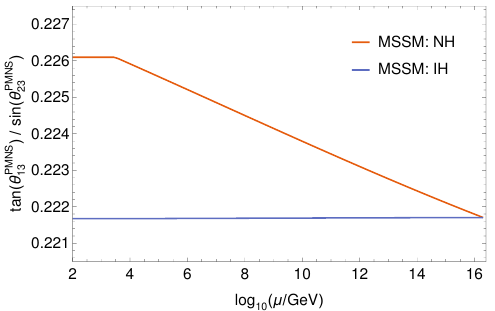
) / sin( θ PMNS ) for both NH and IH in the MSSM with 13 23 and θ PMNS almost cancel 13 23